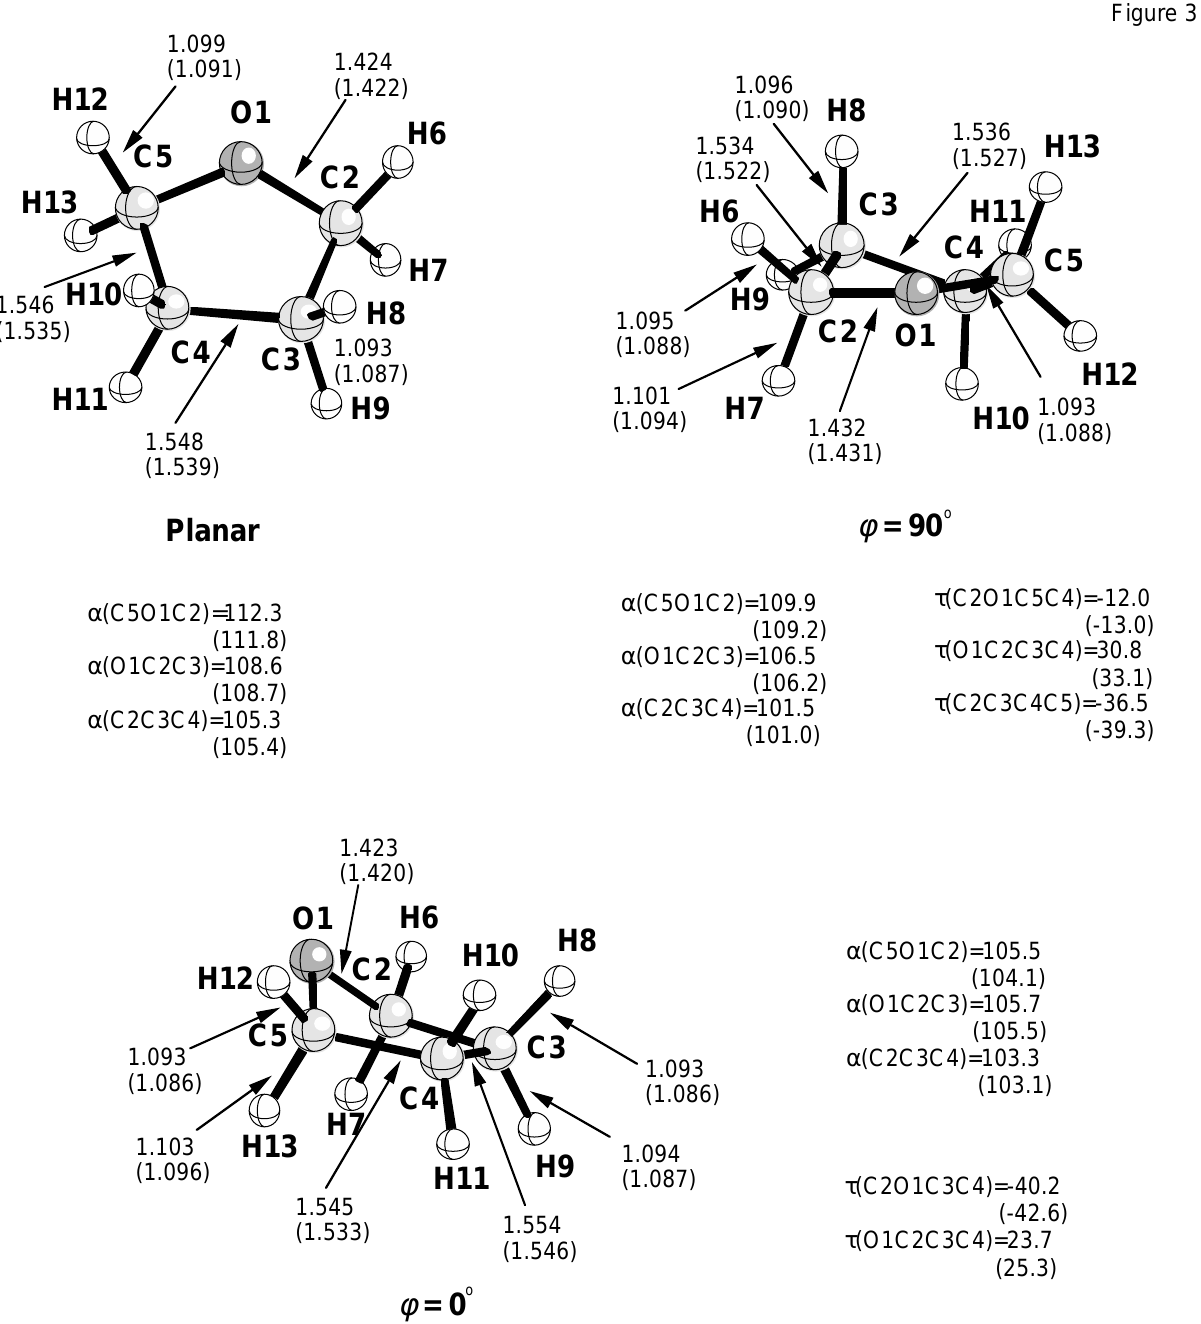
Figure 3: B3LYP/6-31G(d,p) geometries and MBPT(2)/cc-pVTZ geometries (in parentheses) of planar and two puckered ( φ = 0 and 90 ◦ ) THF